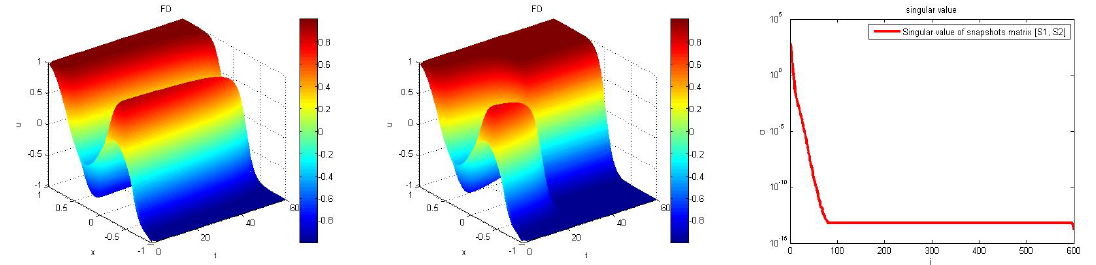
Figure 7. [Test 3] Solution of the full discretized systems with (cid:101) = 0.009 and (cid:101) = 0.011, and the corresponding singular values these snapshots (from left to